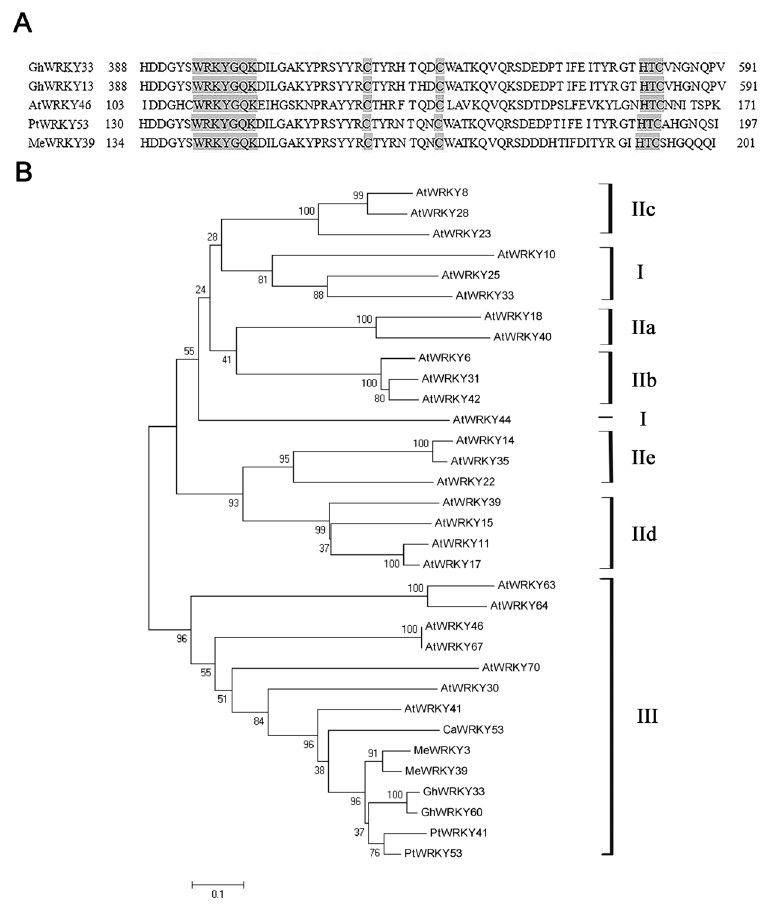
Figure 1. Sequence and phylogenetic analysis of GhWRKY33. ( A ) Sequence alignment of the amino acid sequence of GhWRKY33 with GhWRKY13 (KJ825862), AtWRKY46 (NP_182163), PtWRKY53 (EEE79528), and MeWRKY39 (KT827614). Conserved WRKY domain and zinc-finger motif are shown in grey. ( B ) Phylogenetic relationship of WRKY proteins from different plant species. All the 33 WRKYs protein sequences were subjected to Clustal W using the neighbor-joining method in MEGA 5 and can be divided into three groups (I, II, III), and Group II is further divided into five subgroups (IIa, IIb, IIc, IId, IIe). All the WRKY proteins used for the phylogenetic tree are: AtWRKY6 (NP_564792), AtWRKY8 (NP_199447), AtWRKY10 (NP_175956), AtWRKY11 (NP_567878), AtWRKY14 (NP_564359), AtWRKY15 (NP_179913), AtWRKY17 (NP_565574), AtWRKY18 (NP_001031766), AtWRKY22 (NP_192034), AtWRKY23 (NP_182248), AtWRKY25 (NP_180584), AtWRKY28 (NP_193551), AtWRKY30 (NP_568439), AtWRKY31 (NP_567644), AtWRKY33 (NP_181381), AtWRKY35 (NP_ 001324223), AtWRKY39 (NP_ 001030634), AtWRKY40 (NP_178199), AtWRKY41 (NP_192845), AtWRKY42 (NP_192354), AtWRKY44 (NP_001078015), AtWRKY46 (NP_182163), AtWRKY63 (NP_176833), AtWRKY64 (NP_176829), AtWRKY67 (NP_001117559), AtWRKY70 (NP_191199), CaWRKY53 (NP_001311621), GhWRKY33 (AJT43313), GhWRKY60 (AIE43835), PtWRKY53 (EEE79528), PtWRKY41 (XP_002297983), MeWRKY3 (AMO00371) and MeWRKY39 (KT827614). Gh, Gossypium hirsutum ; At, Arabidopsis thaliana ; Pt, Populus trichocarpa ; Me, Manihot esculenta ; Ca, Capsicum annuum